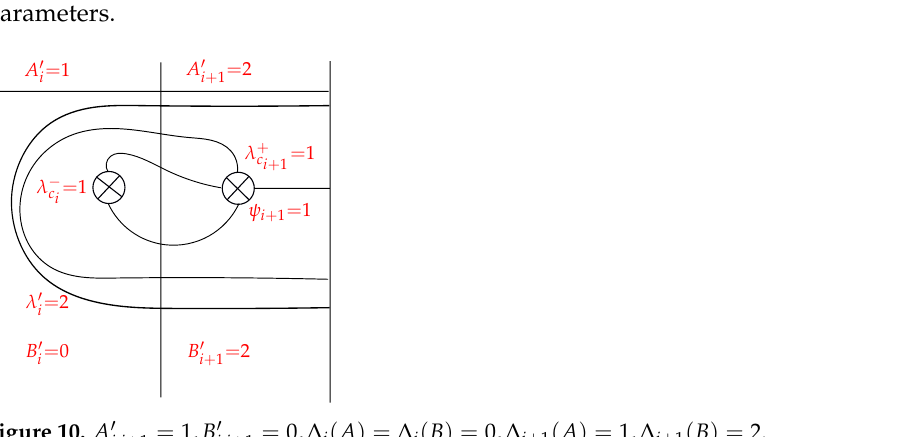
Figure 10. A (cid:48)